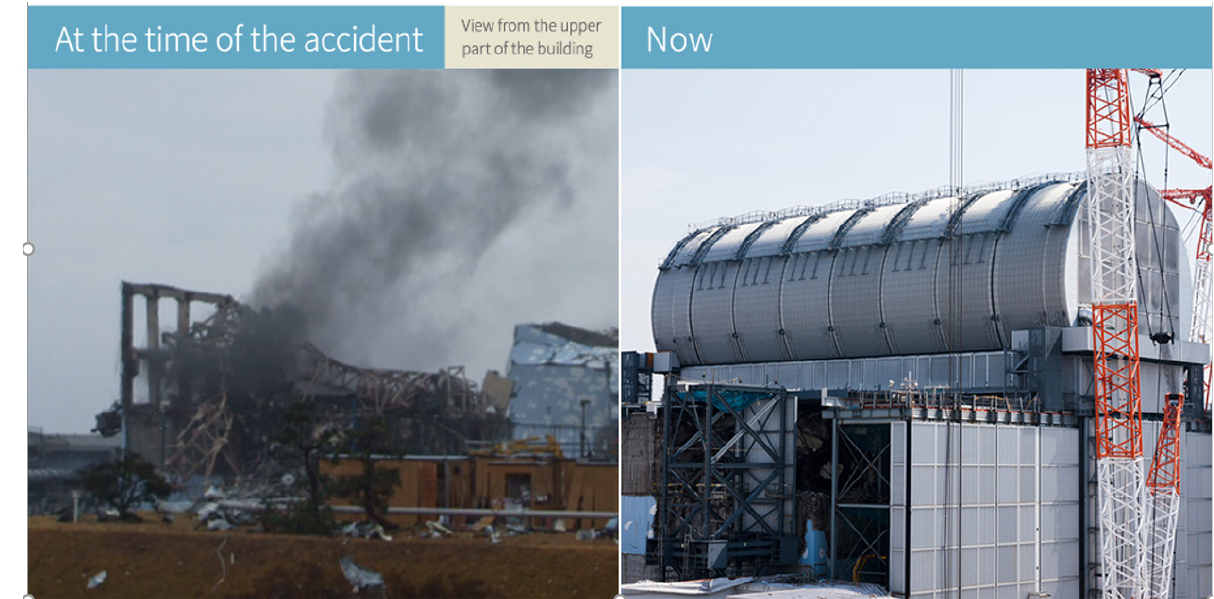
Figure 2. Status of decommissioning in Unit 3 (https://www.tepco.co.jp/en/hd/decommission/progress/about/index-e.html, ac- cessed on 4 October 2021, Courtesy of TEPCO).